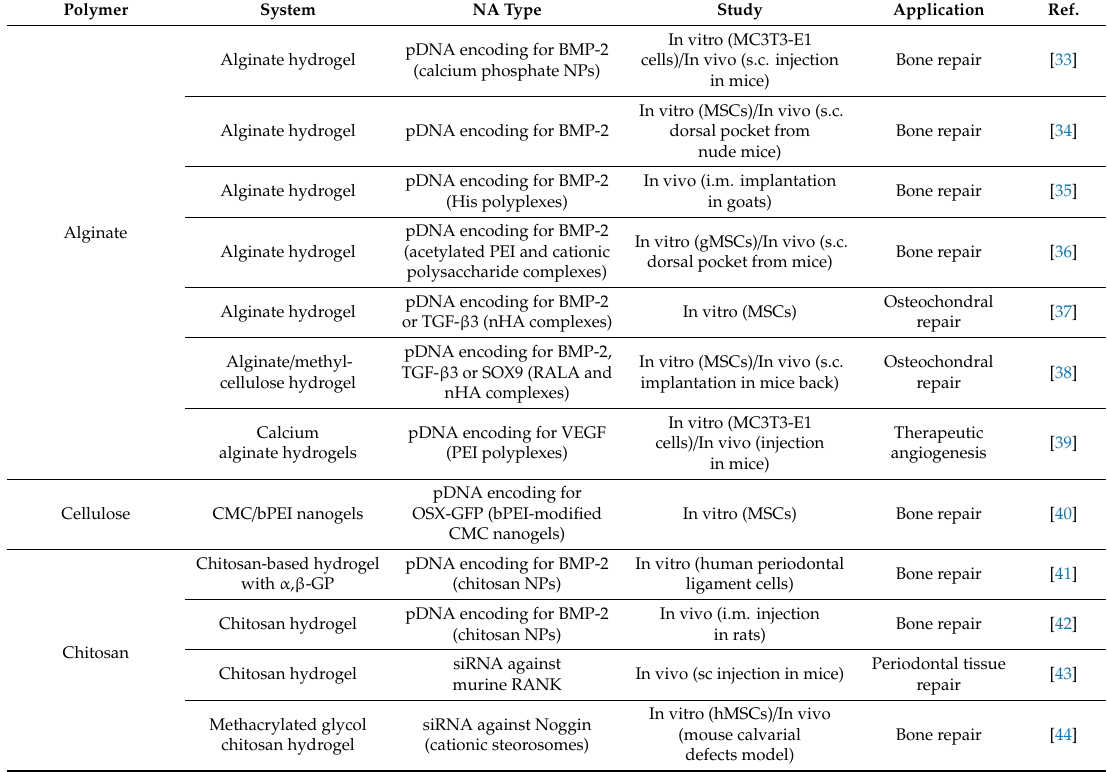
Table 2. Controlled nonviral gene delivery from natural-based